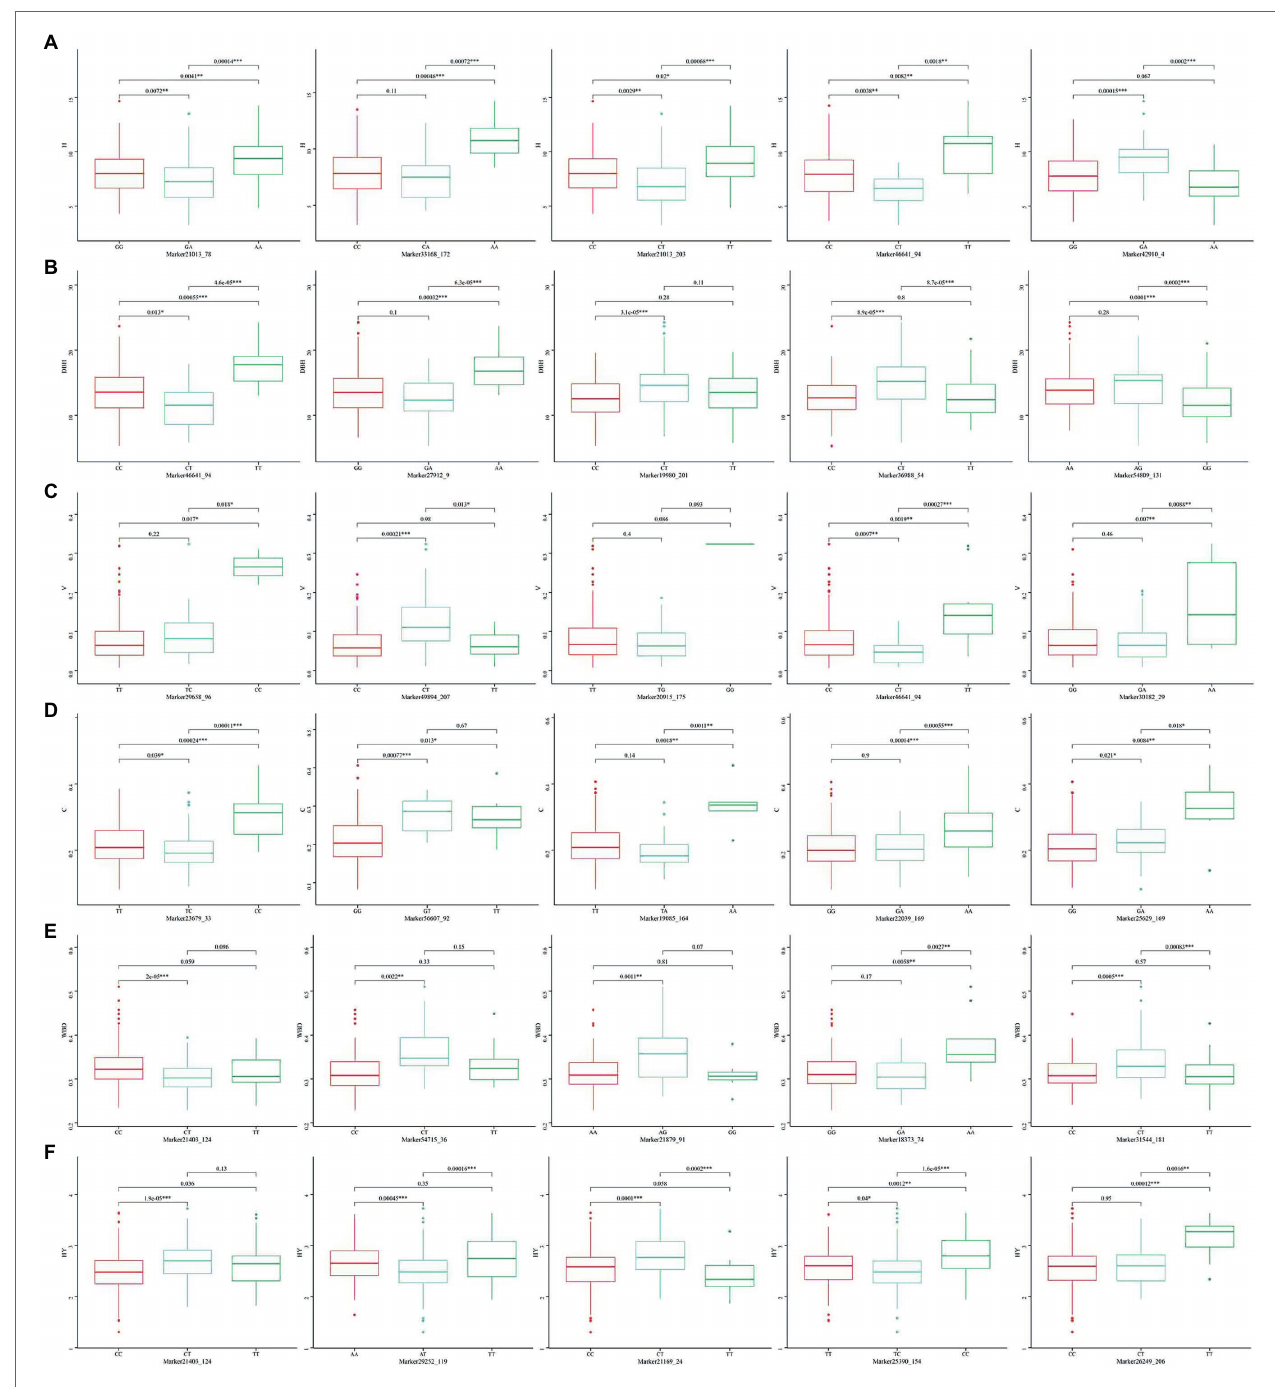
FIGURE 5 | Box plots showing genotype effects of the top five single nucleotide polymorphisms (SNPs) associated with growth-related traits. (A) H, (B) DBH, (C) V, (D) P, (E) WBD, and (F) HY.